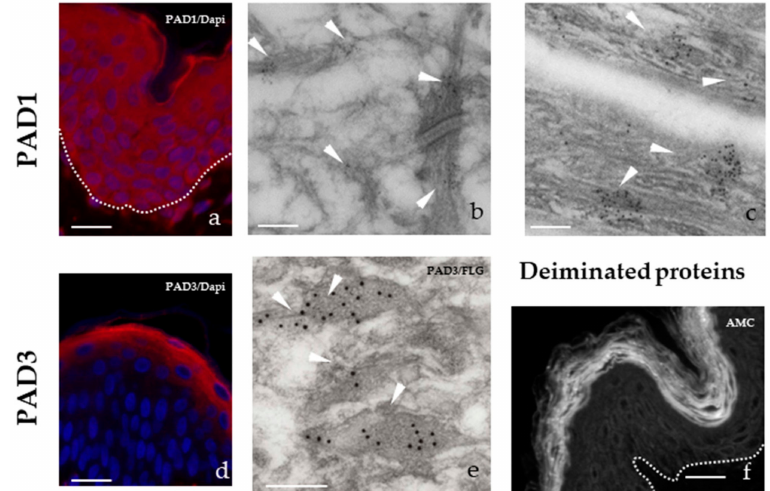
Figure 2. PADs and deiminated proteins in normal human abdominal epidermis. ( a ) Immunofluorescence detection of PAD1 (red). ( b and c ) Immuno-electron microscopy detection of PAD1. White arrowheads point gold beads on intermediate filaments in a granular keratinocyte ( b ) and on the intracorneocyte matrix ( c ). ( d ) Immunofluorescence detection of PAD3 (red). ( e ) Double labelling of PAD3 (small gold beads) and filaggrin (large beads) on keratohyalin granules (arrowheads) in a granular keratinocyte. ( f )ImmunofluorescencedetectionofdeiminatedproteinsusingtheAMCantibodyspecificforchemically modified citrullines, as previously described [29]. The dermo-epidermal junction is indicated by a doted white line ( a and d ). Bar = 50 µ m ( a , d and f ) and 200 nm (b, c, and e). Nuclei are stained in blue (Dapi) ( a and d